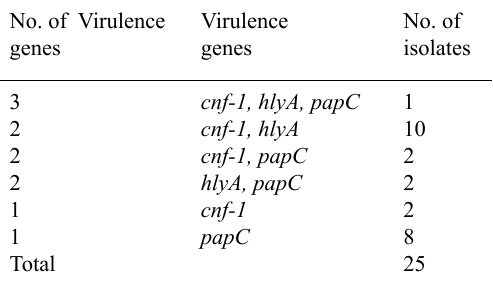
table 4. Distribution of Virulence genes among E. coli